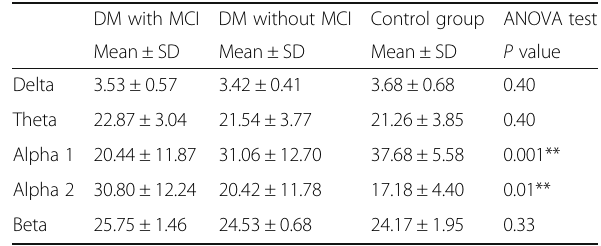
Table 3 The relative power of all frequency bands among the study